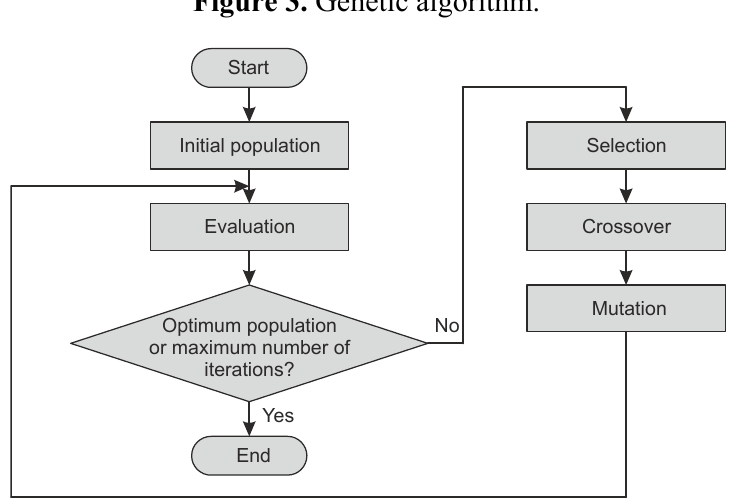
Figure 3. Genetic